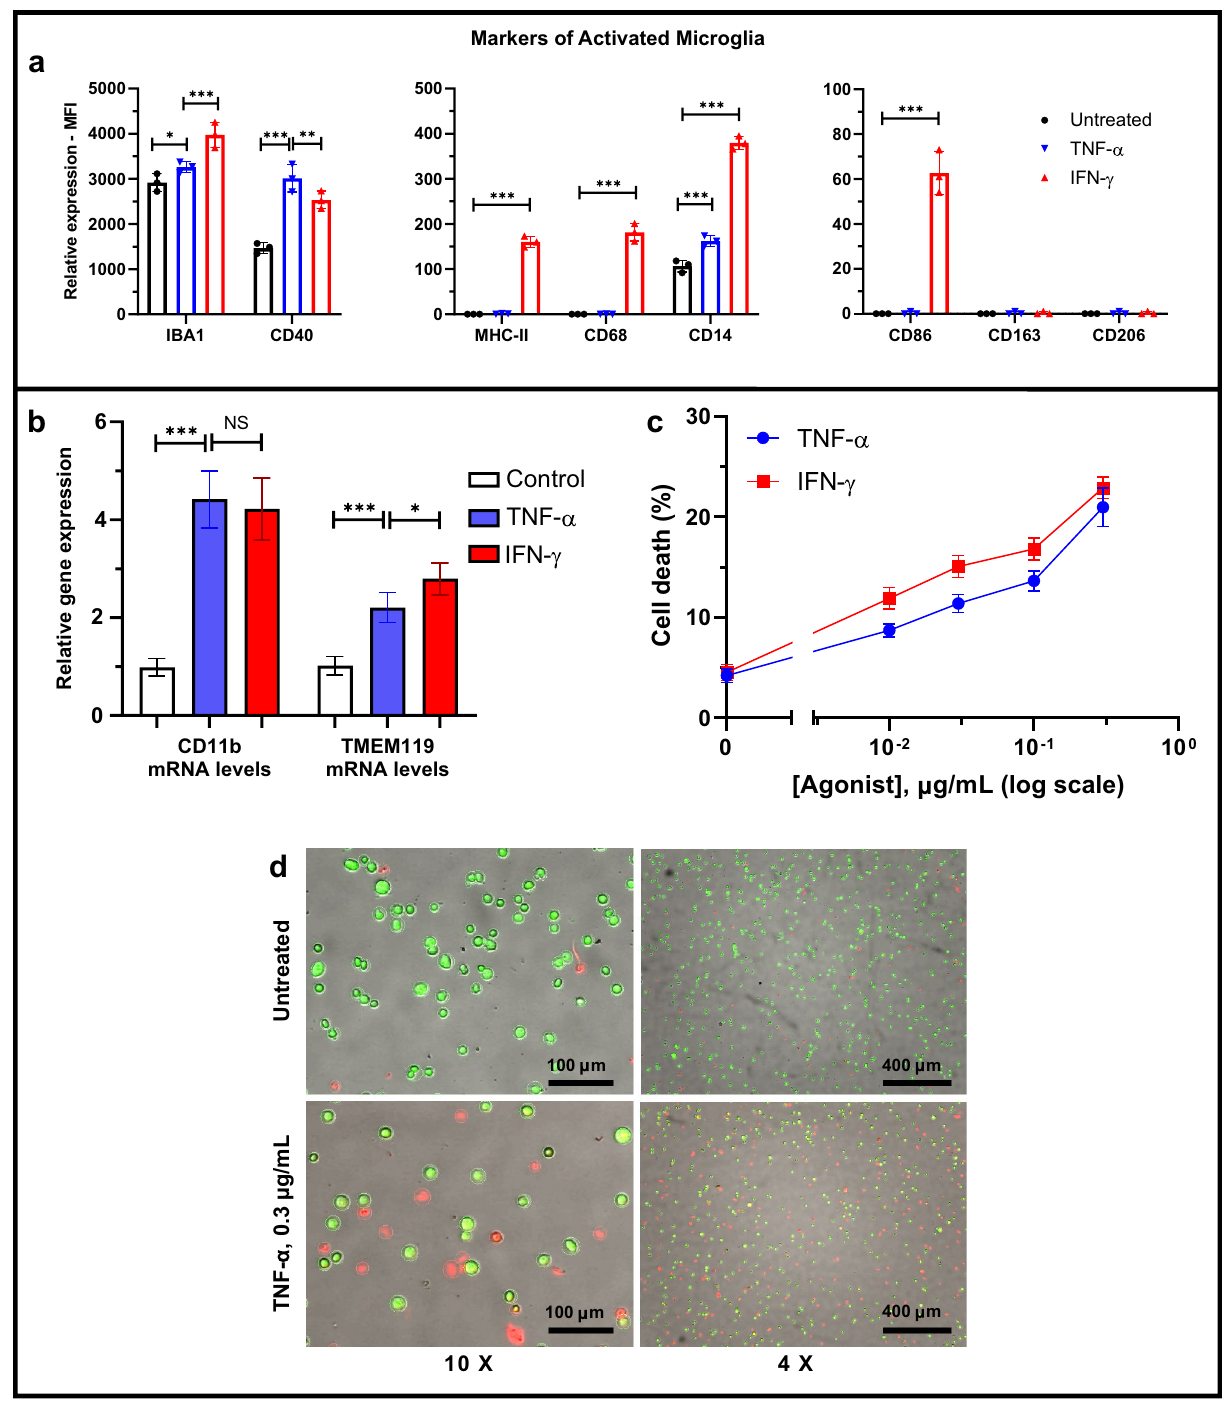
Figure 1. Inflammatory activation of HMC3 human microglia cell line by TNF-α and IFN-γ. ( a ) Flow cytometric analyses demonstrate the increased protein expression of inflammatory microglia biomarkers (IBA-1, CD40, MHC-II, CD68, CD14, and CD86) in the HMC3 cells treated with IFN-γ (0.3 µg/mL, 24 h) (red), but no alteration in the expression of the anti-inflammatory microglia biomarkers CD163 and CD206. TNF-α (0.3 µg/mL, 24 h) (blue) also increases the expression of inflammatory microglia biomarkers (IBA-1, CD40, and CD14). ( b ) q-PCR analysis revealed increased CD11b and TMEM119 expression by HMC3 microglia after addition of 0.3 µg/mL TNF-α or 0.3 µg/mL IFN-γ for 24 h. Fold change is normalized to untreated control. GAPDH was used as an internal control to normalize mRNA level of the gene of measurement in each sample (n = 5 independent experiments). Quantitative analysis ( c ) and representative fluorescence micrographs ( d , displayed at ×10 and ×4 magnification) of the cell viability assay show that both TNF-α and IFN-γ induce cell death in a concentration-dependent manner (0, 0.01, 0.03, 0.1, 0.3 µg/mL) for 24 h in the HMC3 human microglial cells. Fluorescent green features are AO stains of live cells and fluorescent red features are PI stains of dying cells. * p < 0.1, ** p < 0.01, *** p < 0.001, and NS (no significant